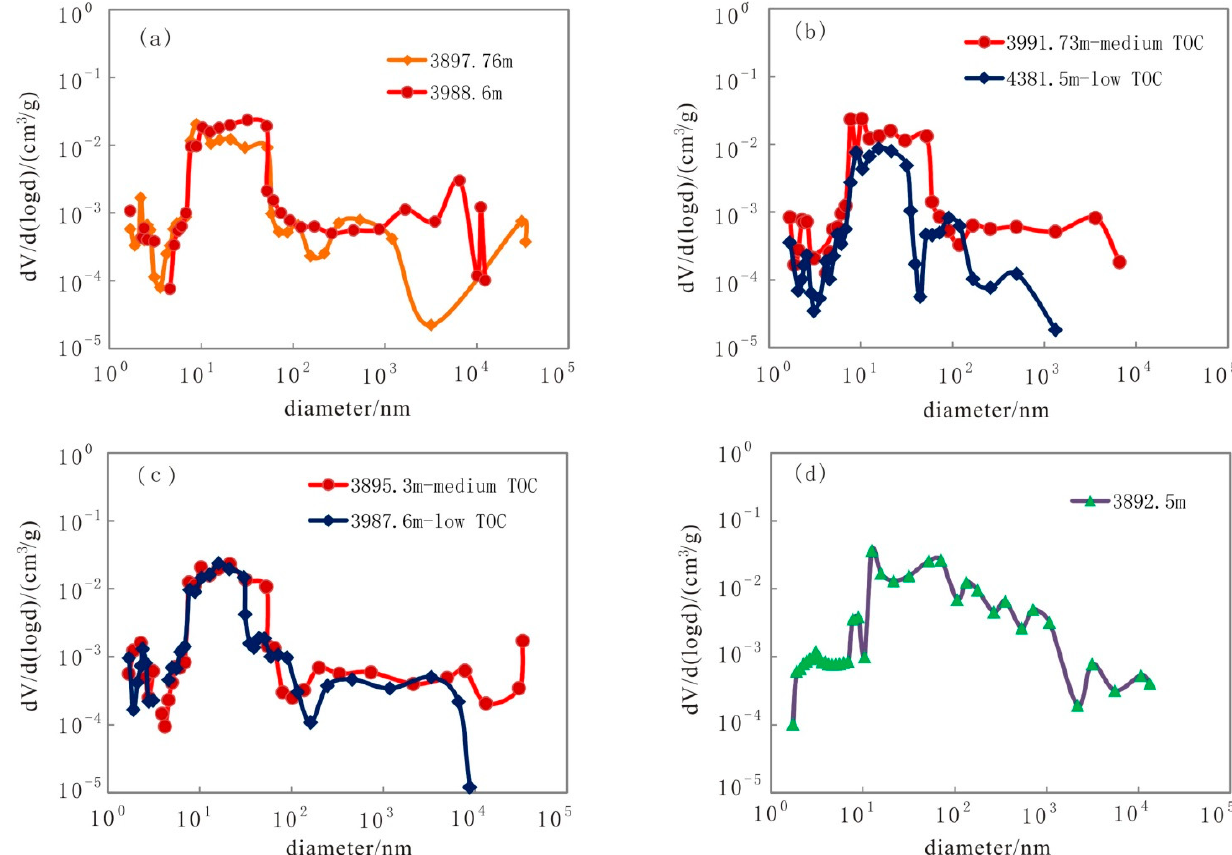
Figure 10. Pore distribution of different shale lithofacies of Es3. ( a ) Thin laminar shale; ( b ) thick laminar shale; ( c ) massive mudstone; ( d ) argillaceous siltstone.